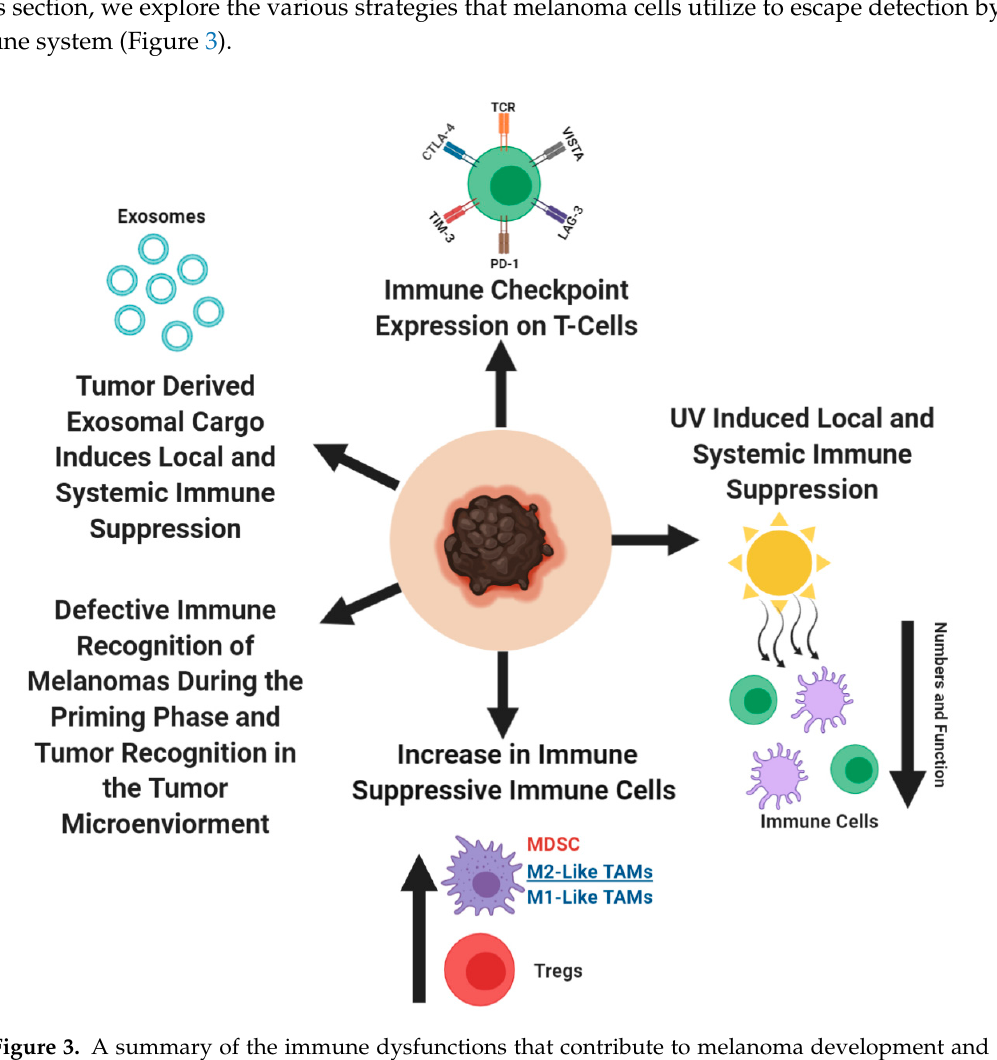
Figure 3. A summary of the immune dysfunctions that contribute to melanoma development and progression. Created with BioRender.com.